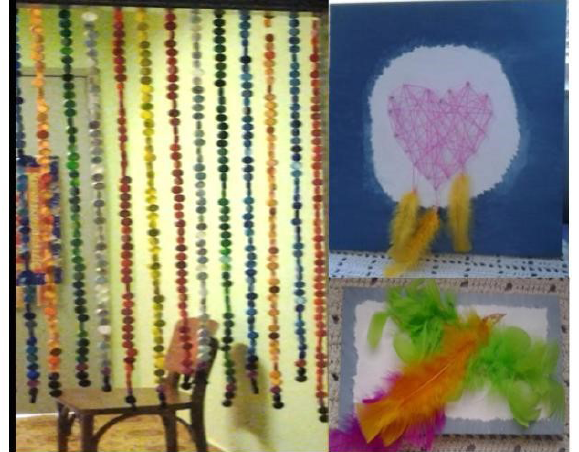
Figure 3. The transition corridor (between the vintage room and the lights room) had a beaded curtain and pictures with different textures on the wall.